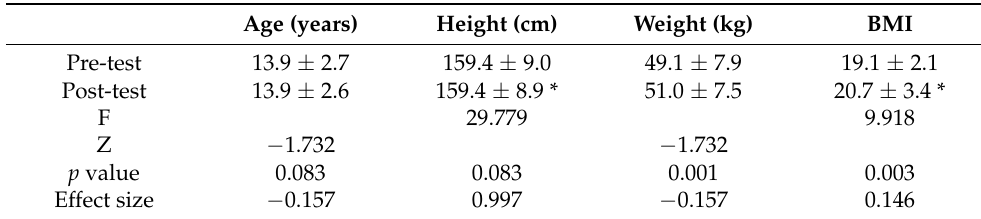
Table 1. Anthropometric measures collected before (pre-test) and after (post-test) the twelve weeks of training